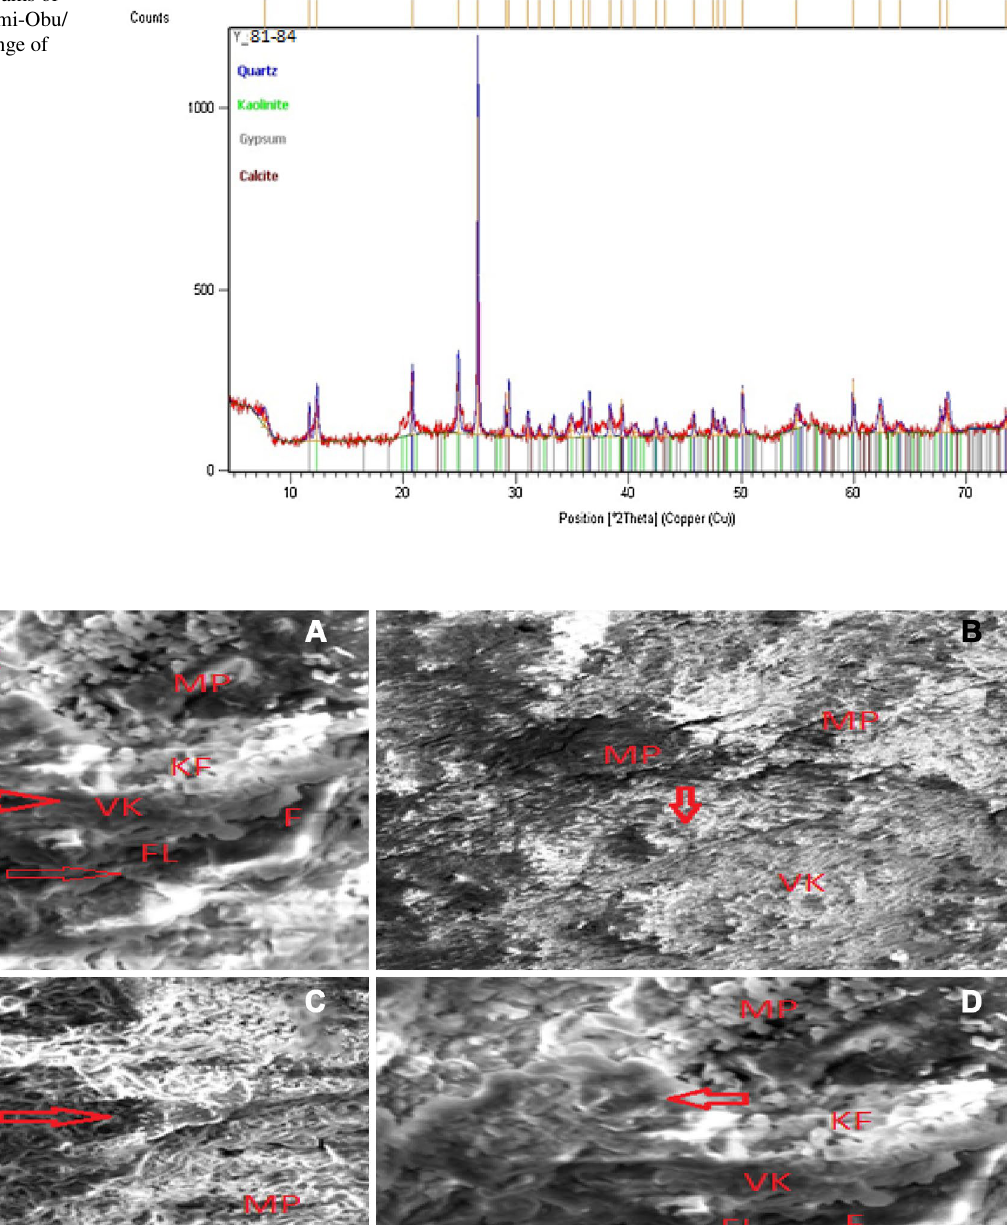
Fig. 15 XRD diffractograms of core sample from Araromi-Obu/ Ago-Alaye at a depth range of 81–84 m